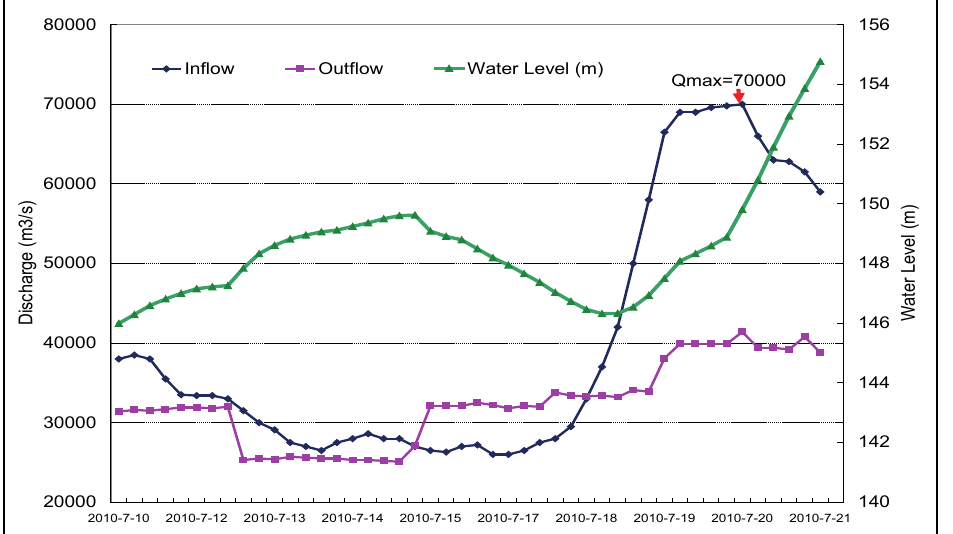
Fig. 7 Hydrograph of TGR operation for flood management in July